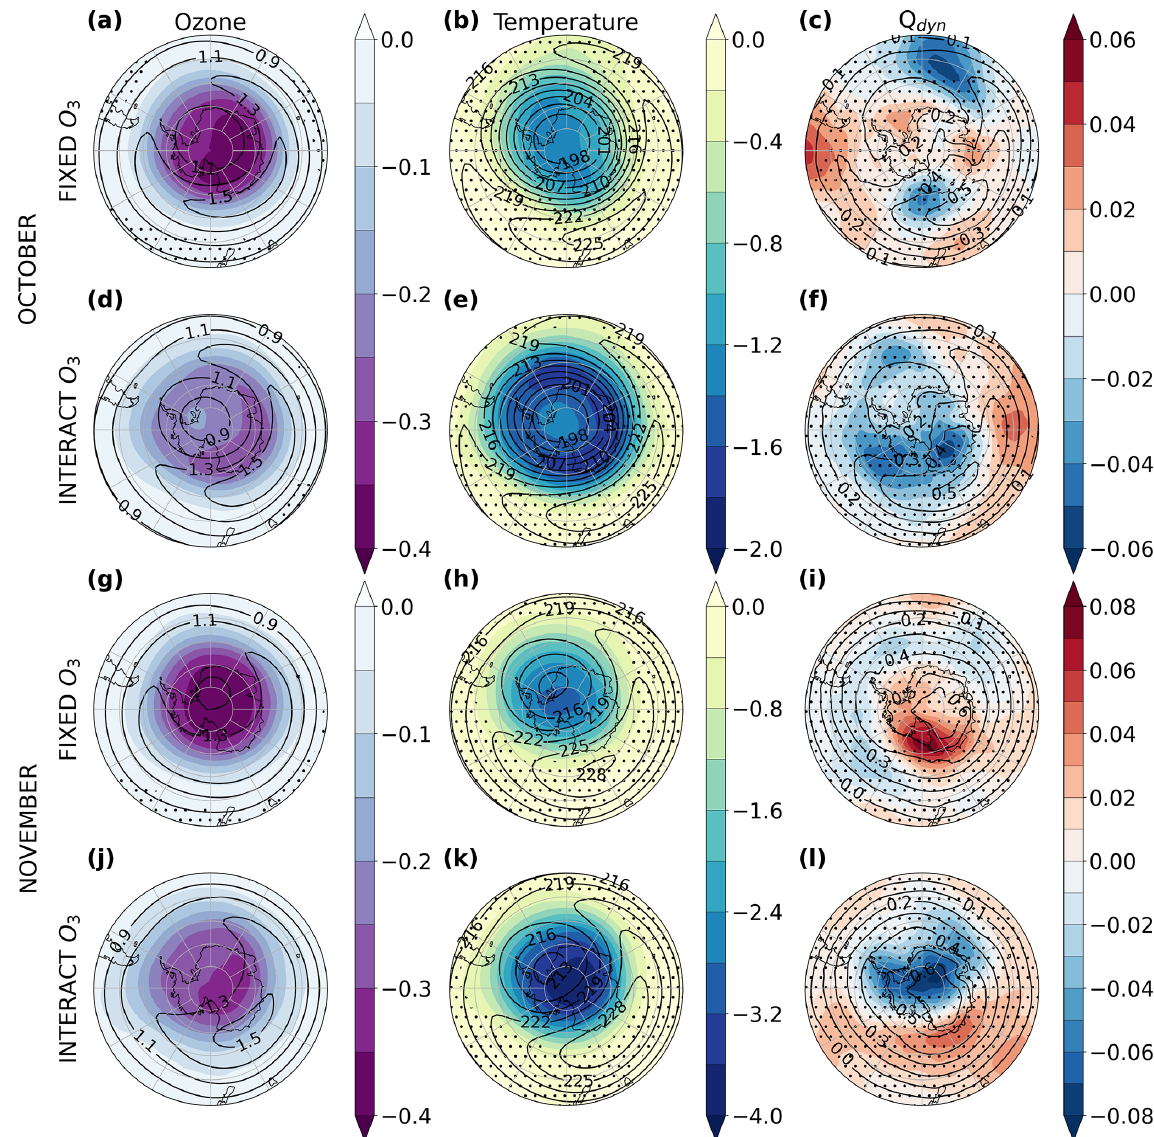
Figure 7. Polar stereographic maps of the October (a–f) and November (g–l) trends in ozone ( a, d, g, j ; ppmv per decade), temperature ( b, e, h, k ; K per decade), and dynamical heating rate ( c, f, i, l ; Kd − 1 per decade) at 100hPa for FIXED O 3 (a–c, g–i) and INTERACT O 3 (d–f, j–l) over 1958–2002 (color shading). Stippling masks regions where the trends are not significant at the 95% confidence level. The overlaying contours show the respective climatologies for